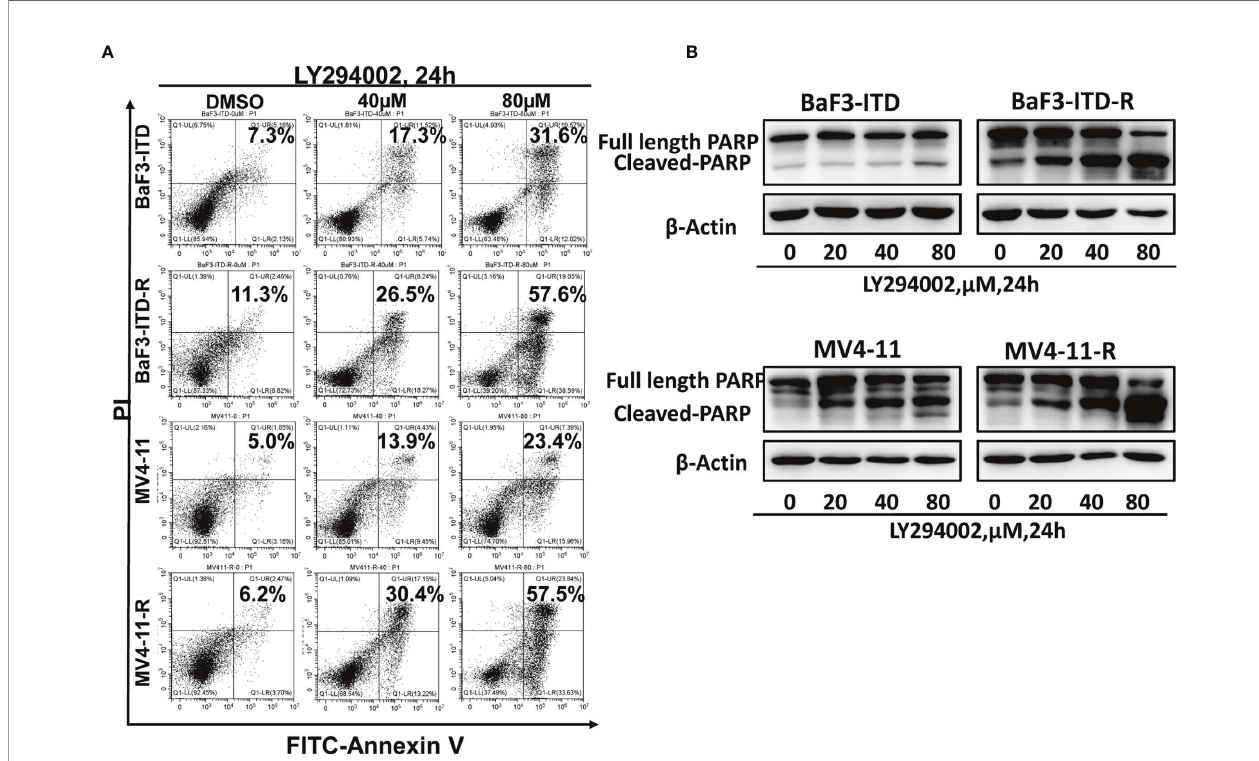
FIGURE 5 | Drug-resistant cells are more sensitive to LY294002. (A) Comparison of the apoptotic effect induced by LY294002 in two pairs of cell lines. Cells were exposed to LY294002 at the indicated concentrations for 24 hours, and the apoptotic cells were stained with Annexin-V and PI for 15 mins and detected by fl ow cytometry in one hour. Data represent three independent experiments. (B) Cells were treated with LY294002 for increasing concentrations, with PARP and cleaved PARP detected by western blotting. b -actin was used as a loading